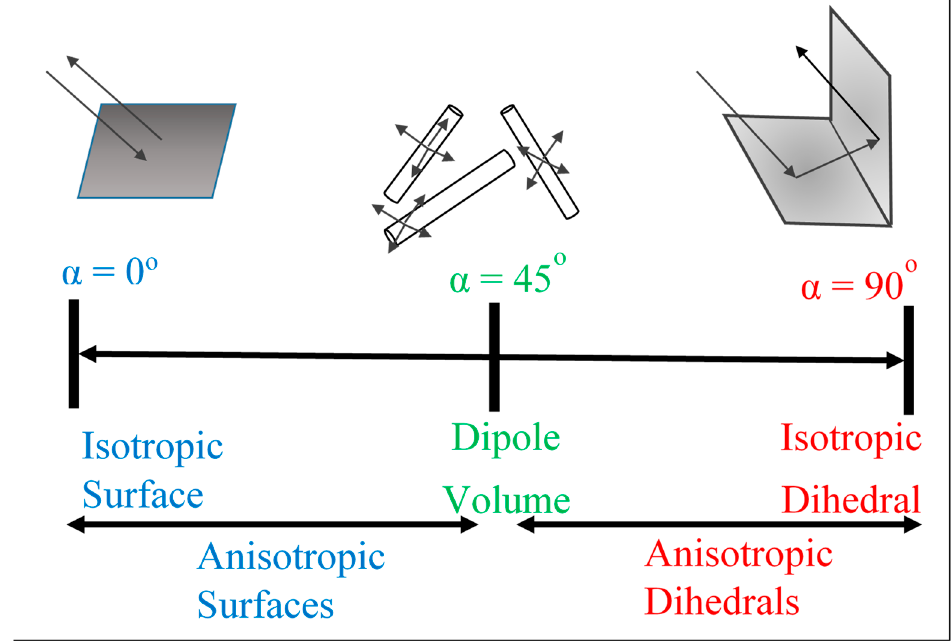
Figure 4. Illustration of the dominant scattering mechanisms as expressed by the mean alpha scattering angle. Scattering ranging from α = 0 to α = 90.